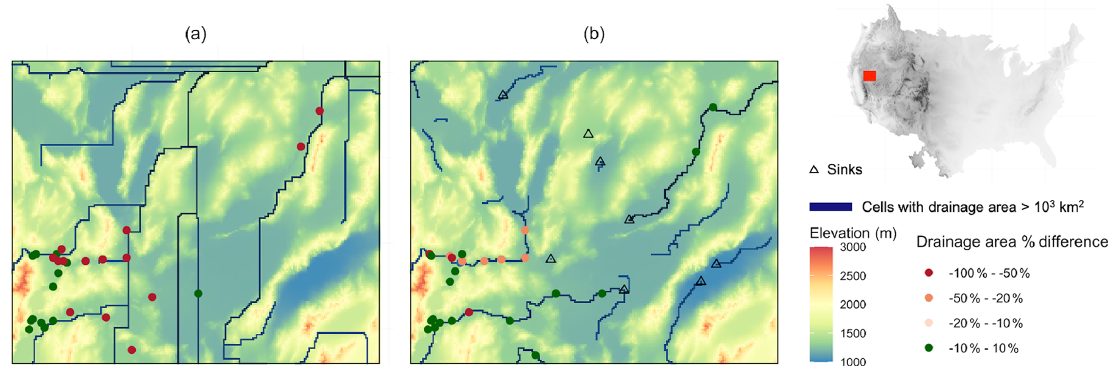
Figure 5. Panels (a) and (b) are maps illustrating the effect of sinks in drainage network derivation, a selected domain in the Great Basin (the highlighted red box in the upper-right CONUS map). In panels (a) and (b) , the background is the elevation map; blue cells are the cells with drainage area over 1000km 2 from processing; colored dots represent the percentage difference of drainage area between processed and USGS observations (a) without sinks and (b) with pre-defined sinks.